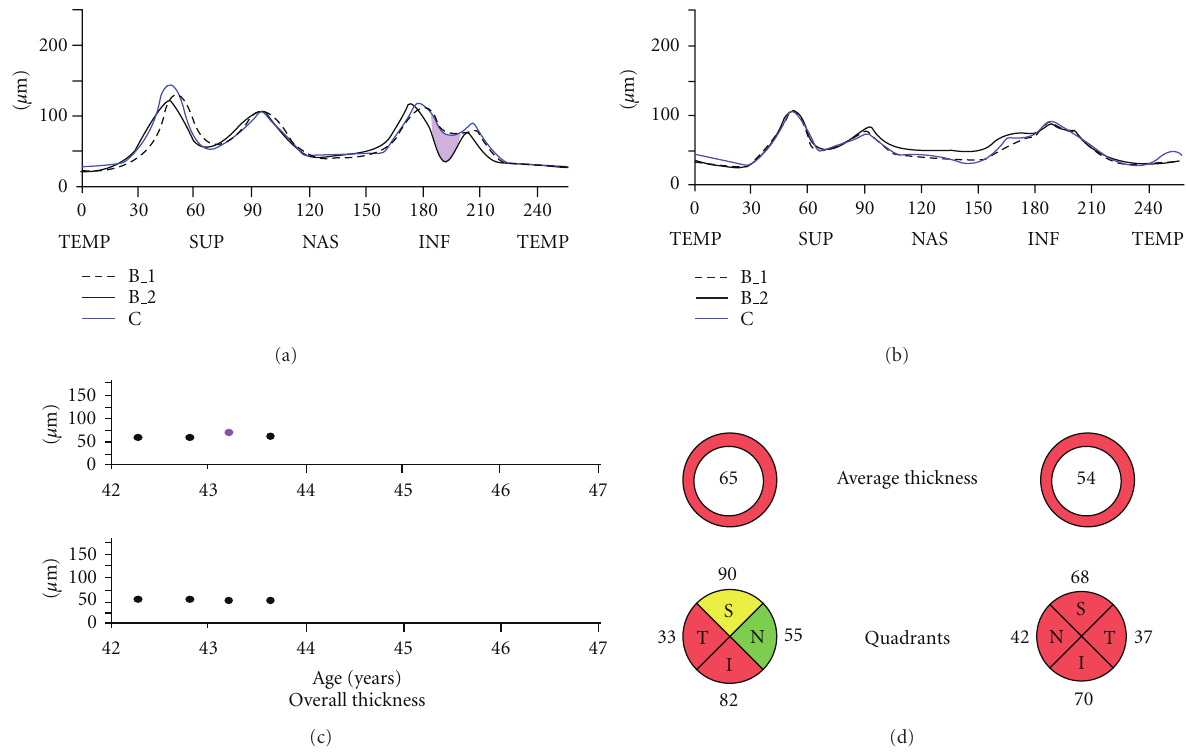
Figure 4: Patient with multiple sclerosis and severe bilateral RNFL thinning with history of optic neuritis. SD-optical coherence tomography analysis found no further loss during a